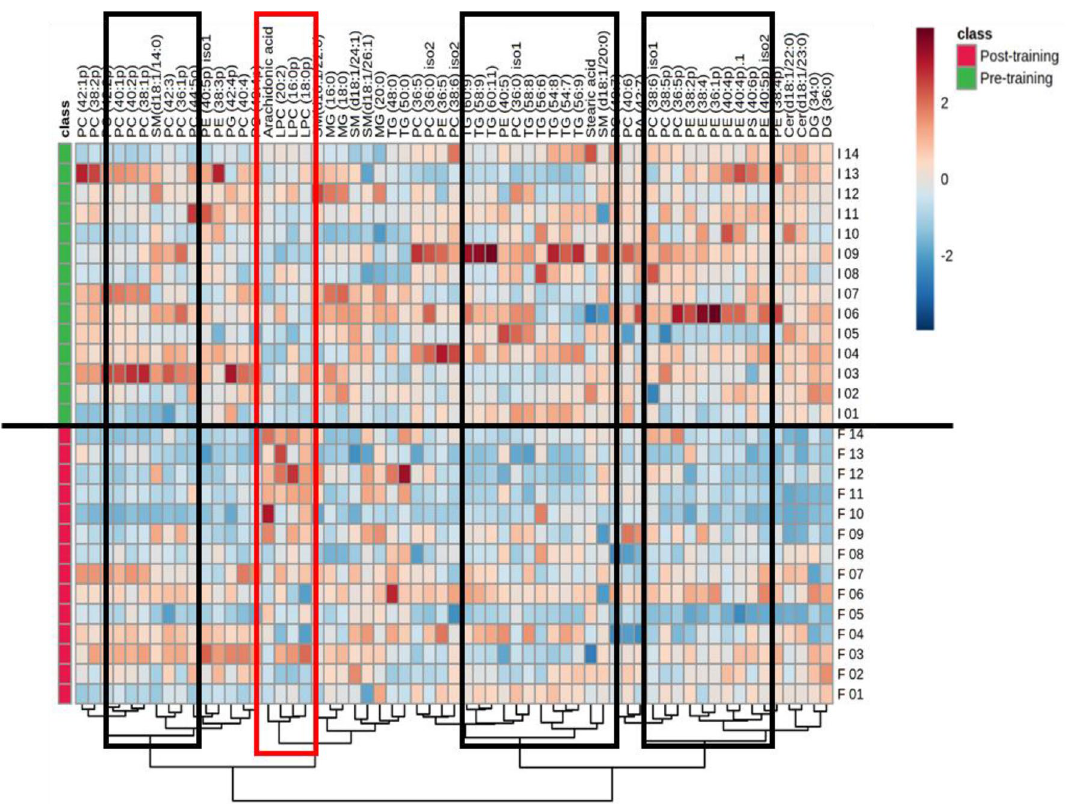
Figure 4. Heat map analysis of hierarchical clustering of plasma lipid species of obese women after combined physical exercise. In this type of analysis, each colored cell on the map corresponds to a concentration value,